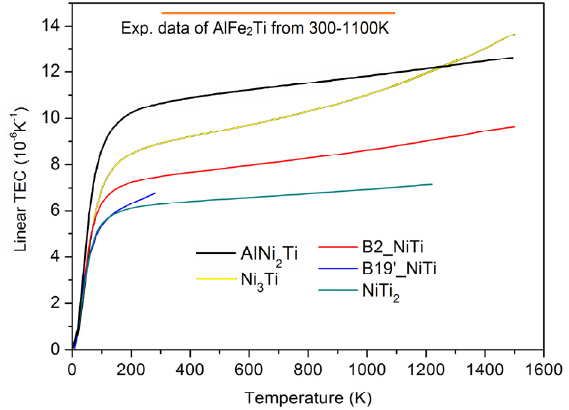
Figure 7. Linear thermal expansion coefficients of AlNi 2 Ti and Ni-Ti binary compounds as a function of temperature [52].